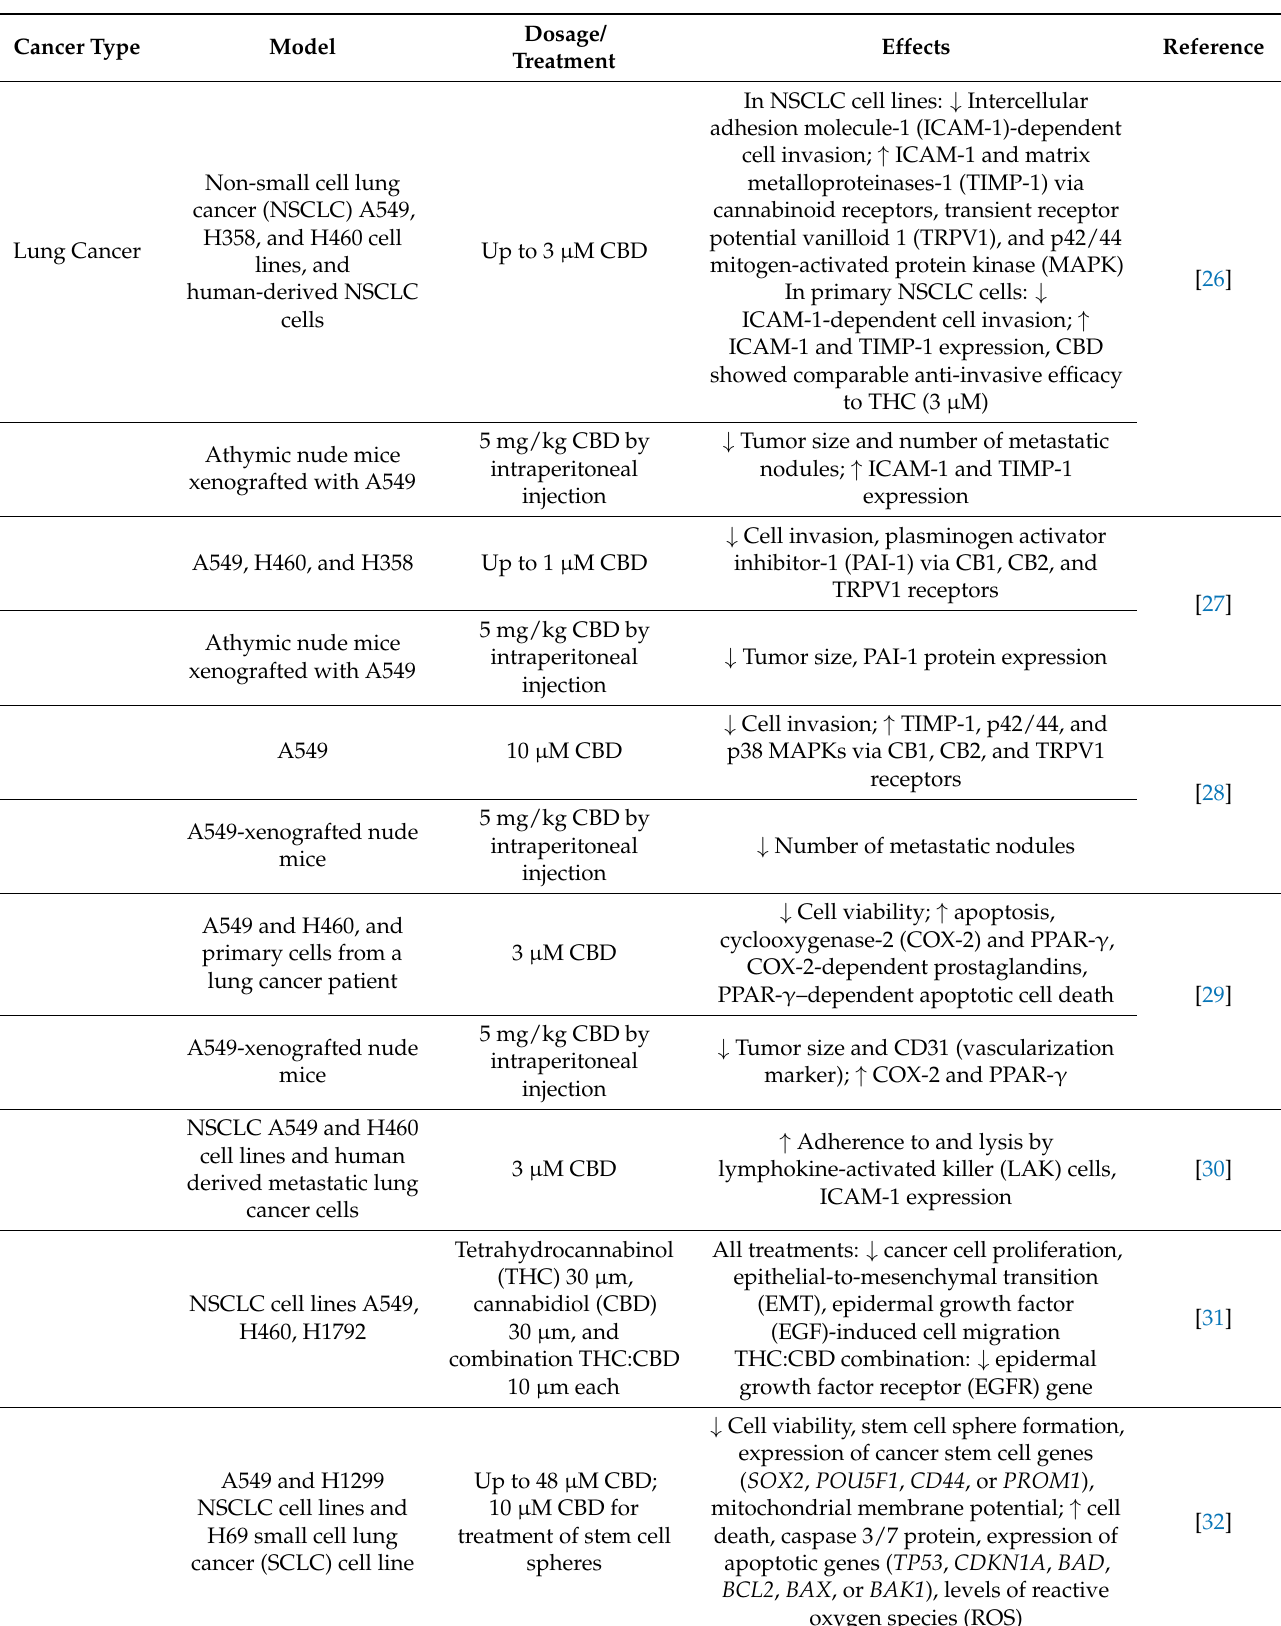
Table 1. Anticancer studies of